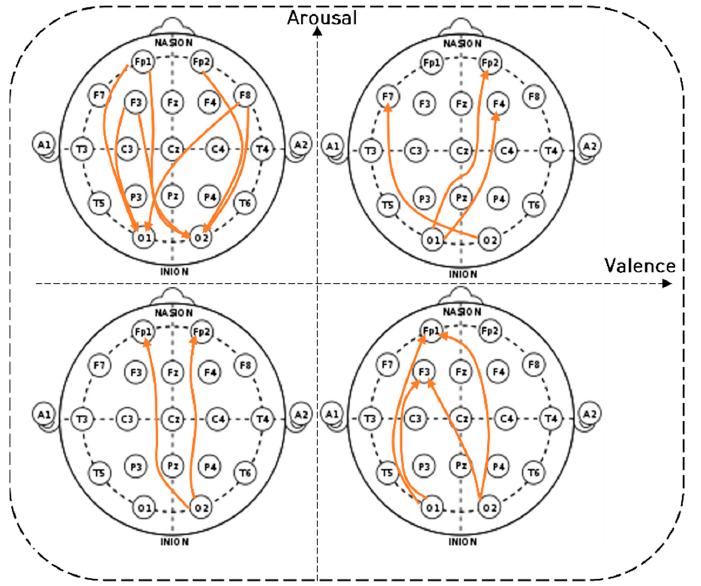
Figure 12. The long-distance connectivity of the occipital and frontal lobes (LD_O-F connectivity) of the beta wave.